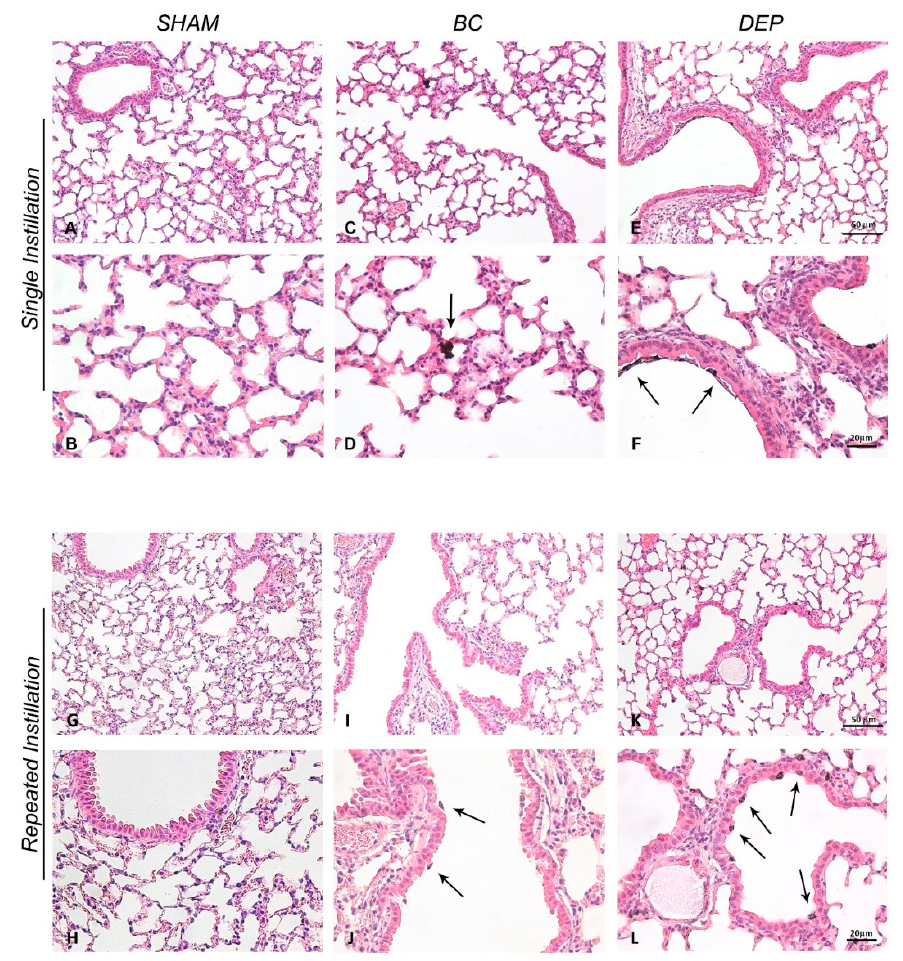
Figure 1. Lung histological analysis. Representative histological images of lung after single ( A – F ) or repeated ( G – L ) intratracheal instillation with 50 µ g of BB ( C , D , I , J ) or DEP ( E , F , K , L ) in 100 µ L 0.9% NaCl. Arrows indicate phagocytic cells containing particles in alveolar space and interstitium. ( A , C , E ; G , I , K ) Bars = 50 μ m; ( B , D , F ; H , J , K ) Bars = 20 μ m.